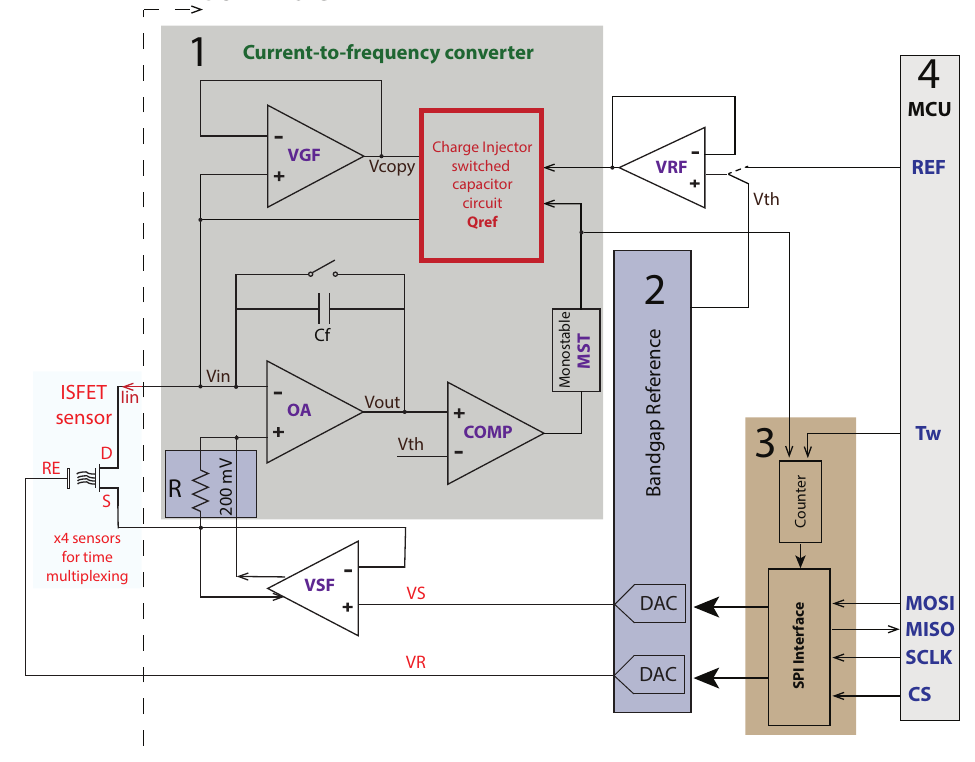
Figure 2. ANTIGONE ASIC Architecture. The main blocks are (1) the current-to-frequency converter, (2) the bandgap reference voltage, (3) the Serial Peripheral Interface (SPI) interface and the counter. The Microcontroller Unit (MCU) noted as (4) that is off-chip is the master/primary and controls the ASIC that is used in slave/secondary mode. On-chip analog multiplexers are connecting the input of the Current-to-Frequency Converter (CFC) to the ISFET